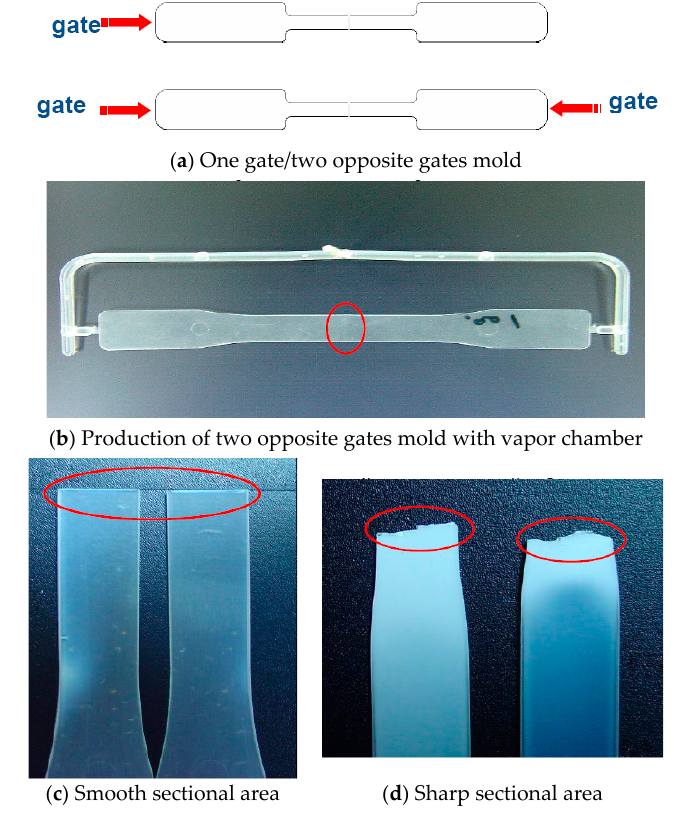
Figure 8. One gate mold with no VCRHCS and two gates mold with VCRHCS.